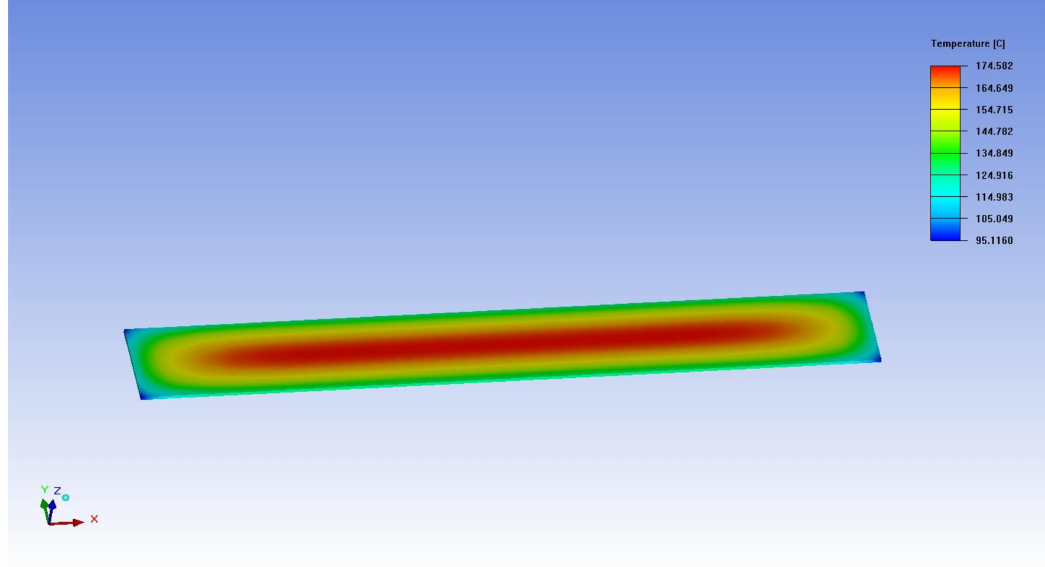
Figure A2. The calculation result of